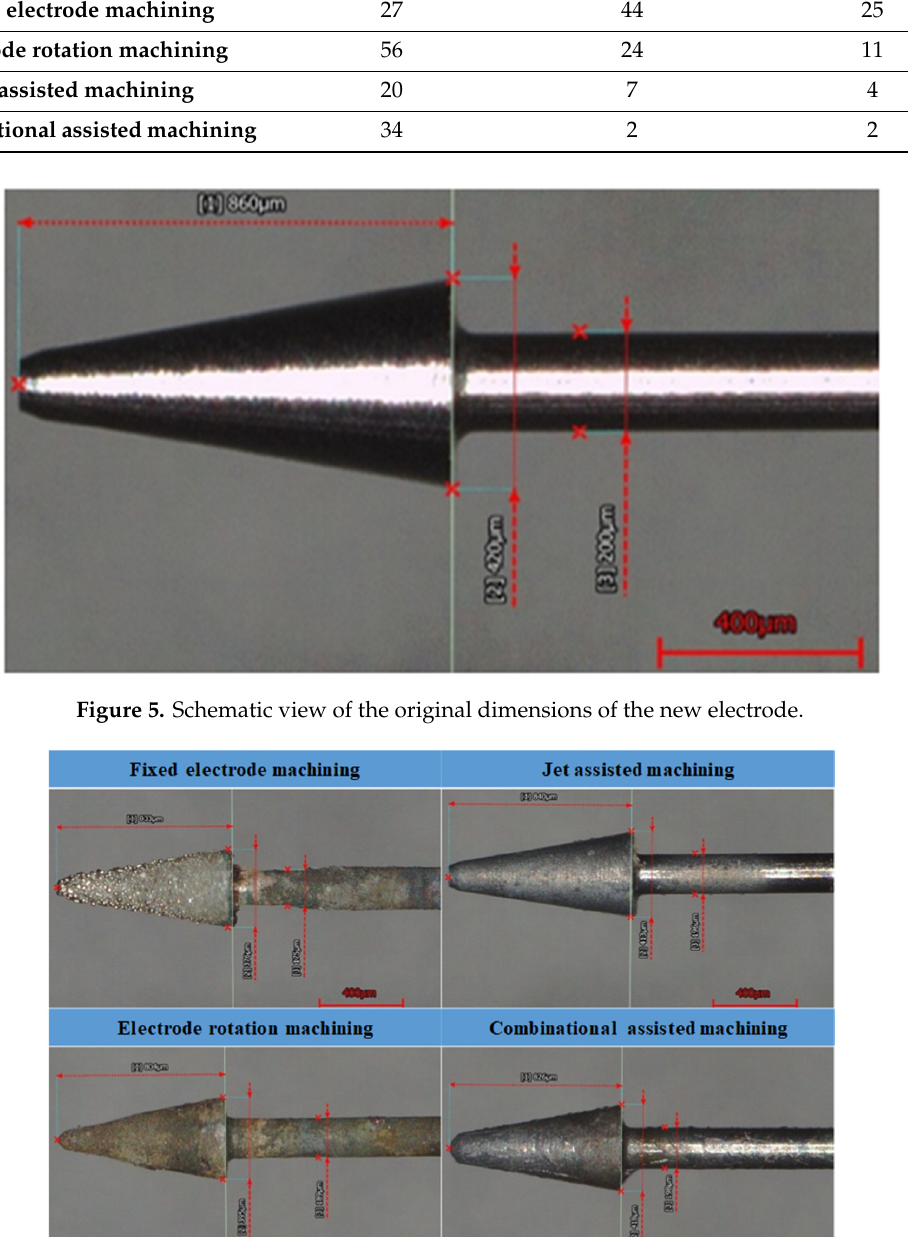
Figure 6. Electrode wear conditions of the different machining methods.